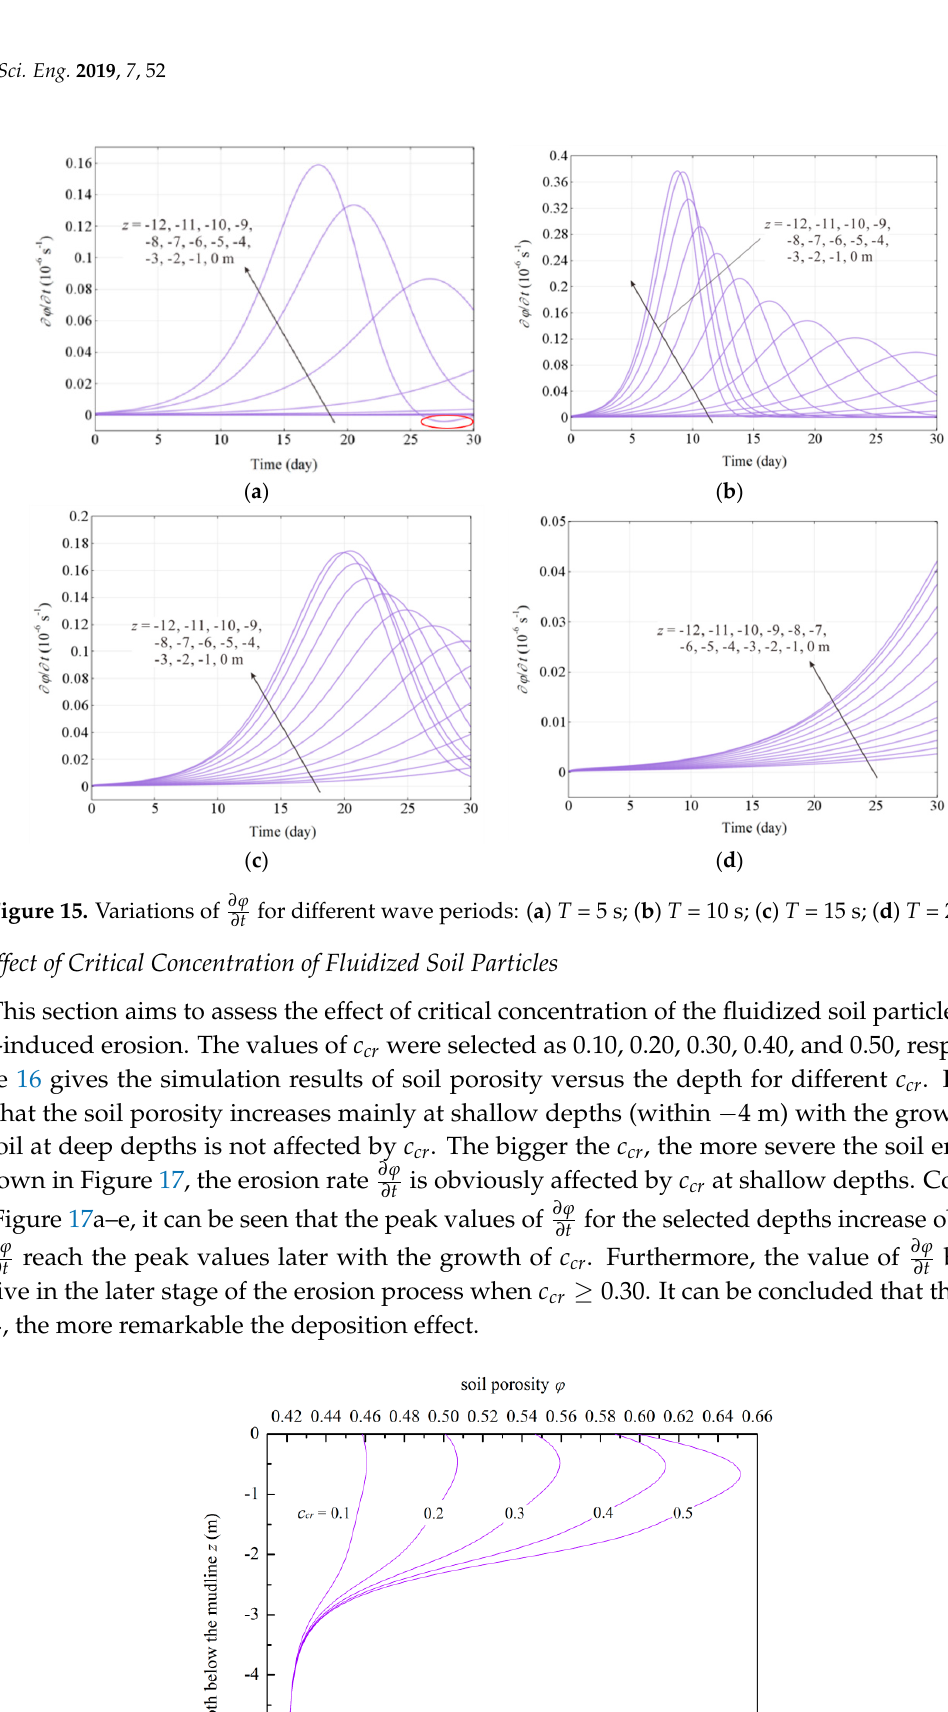
Figure 14. Variations of the soil porosity for different wave periods. 304